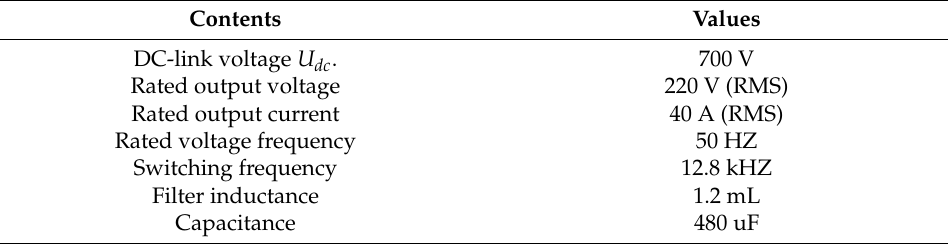
Table 3. Simulation parameters and real system 1 parameters of three-phase PWM converter.